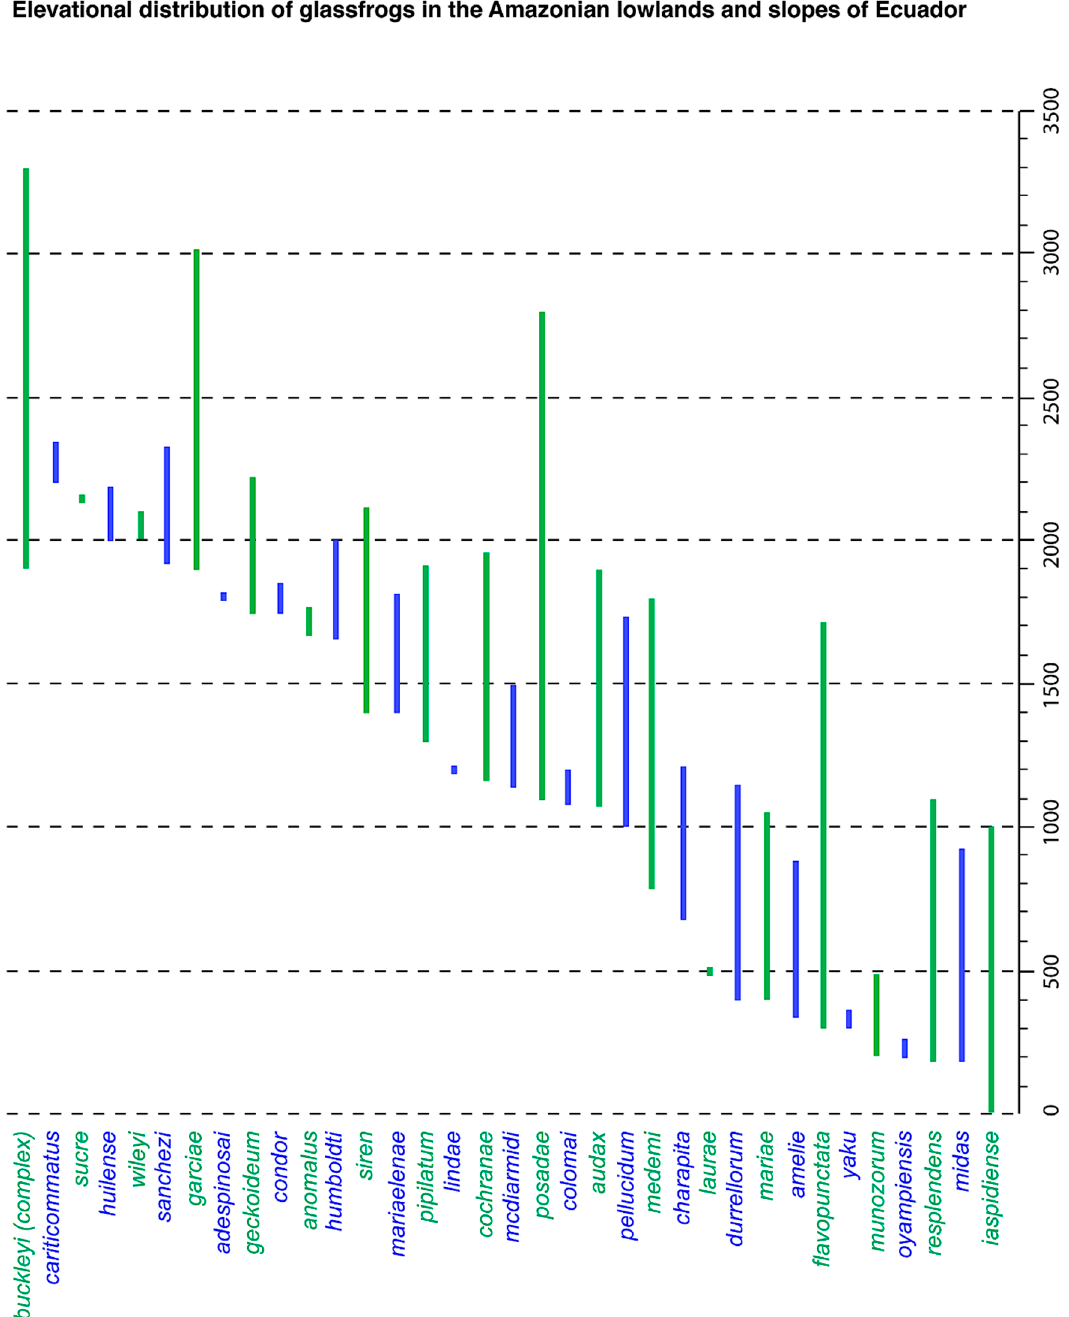
Figure 229. Elevational distribution of glassfrogs on the Amazonian lowlands and Amazonian slopes of the Ecuadorian Andes.